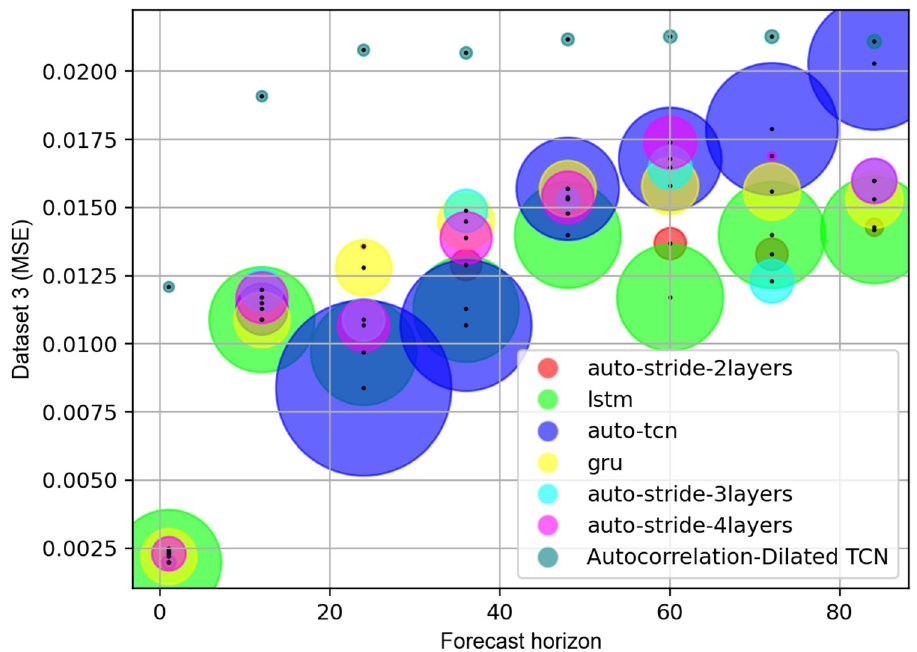
Figure 4. Comparison between models with respect to performance and complexity. The comparison is conducted on the CNU dataset. The x-axis depicts MSE error, and the y-axis depicts the forecast horizontal at eight milestones (1, 12, 24, 36, 48, 60, 72, and 84 h). A circle represents a model whose color represents its category, and the circle radius describes its complexity.